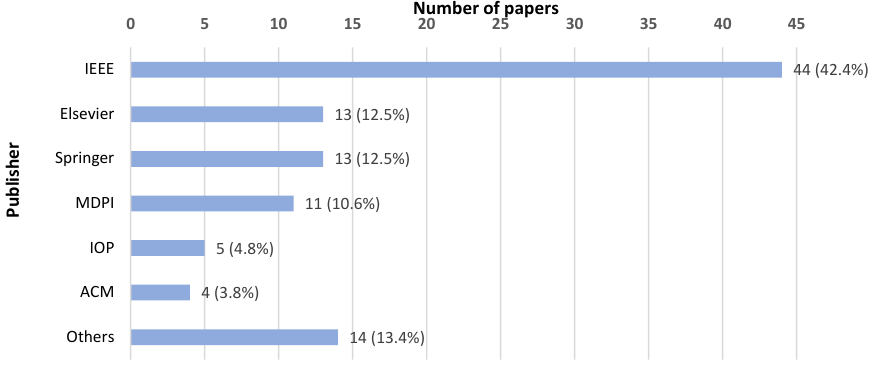
Figure 3. Distribution of papers per publisher related to blockchain applications in the agriculture